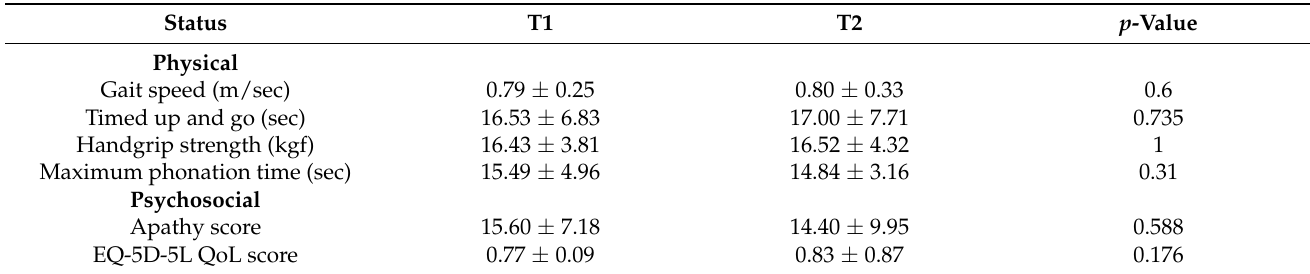
Table 2. Physical and Psychological Status in the Female